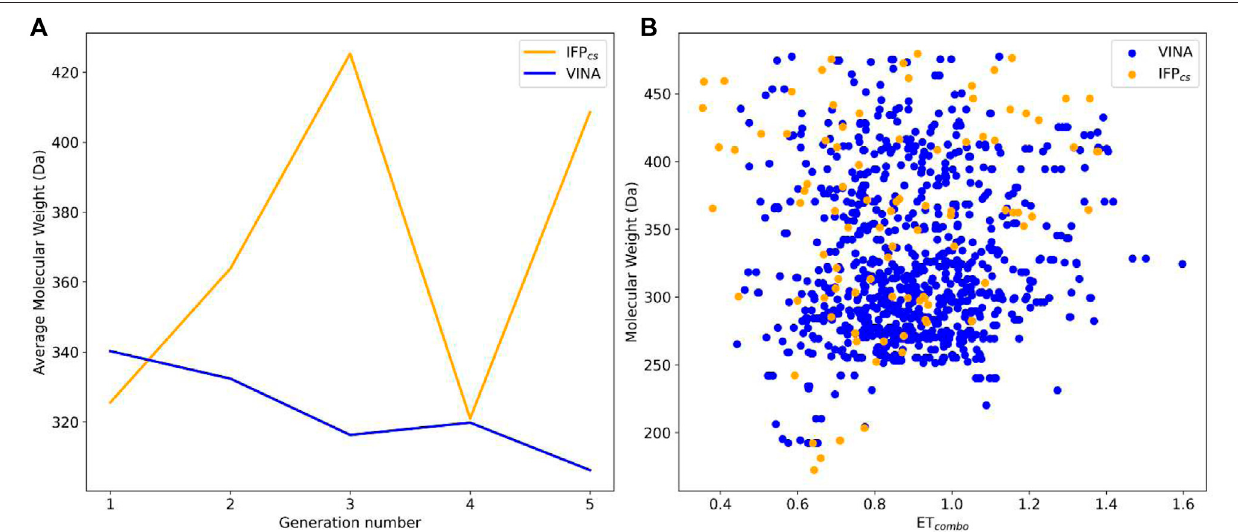
FIGURE8| ComparisonoftheperformanceofthetwoAutogrowprotocolsinthebenchmarklead-optimizationrunsregardingtheirabilitytogeneratecompounds thatpassthepharmacophore fi lter.TheVINAprotocolisreportedasablueline,whiletheIFP CS oneisreportedasanorangeline.Panel (A) depicts,foreachprotocol,the average molecular weight of compounds within the population that pass the pharmacophore fi lter on a per-generation basis. The vertical axis reports the molecular weight, while the horizontal axis reports the generation number. Panel (B) depicts, for each protocol, the distribution of generated compounds that pass the pharmacophore fi lter regarding their molecular weight and the similarity of shape and electrostatic properties to crystal inhibitors taken as reference. The vertical axis reports the average molecular weight in Da, while the horizontal axis reports the ET combo value. The blue dots represent compounds generated by the VINA protocol, while the orange dots represent compounds generated by the IFP CS one.